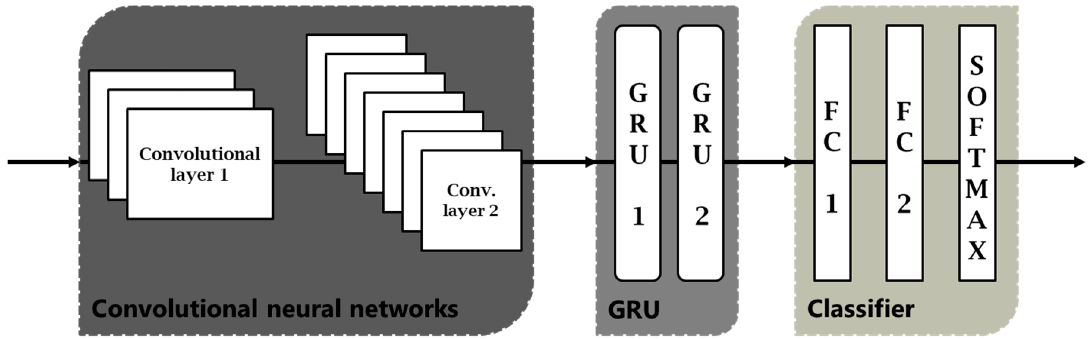
Figure 6. Deep neural network architecture for maneuver classification.